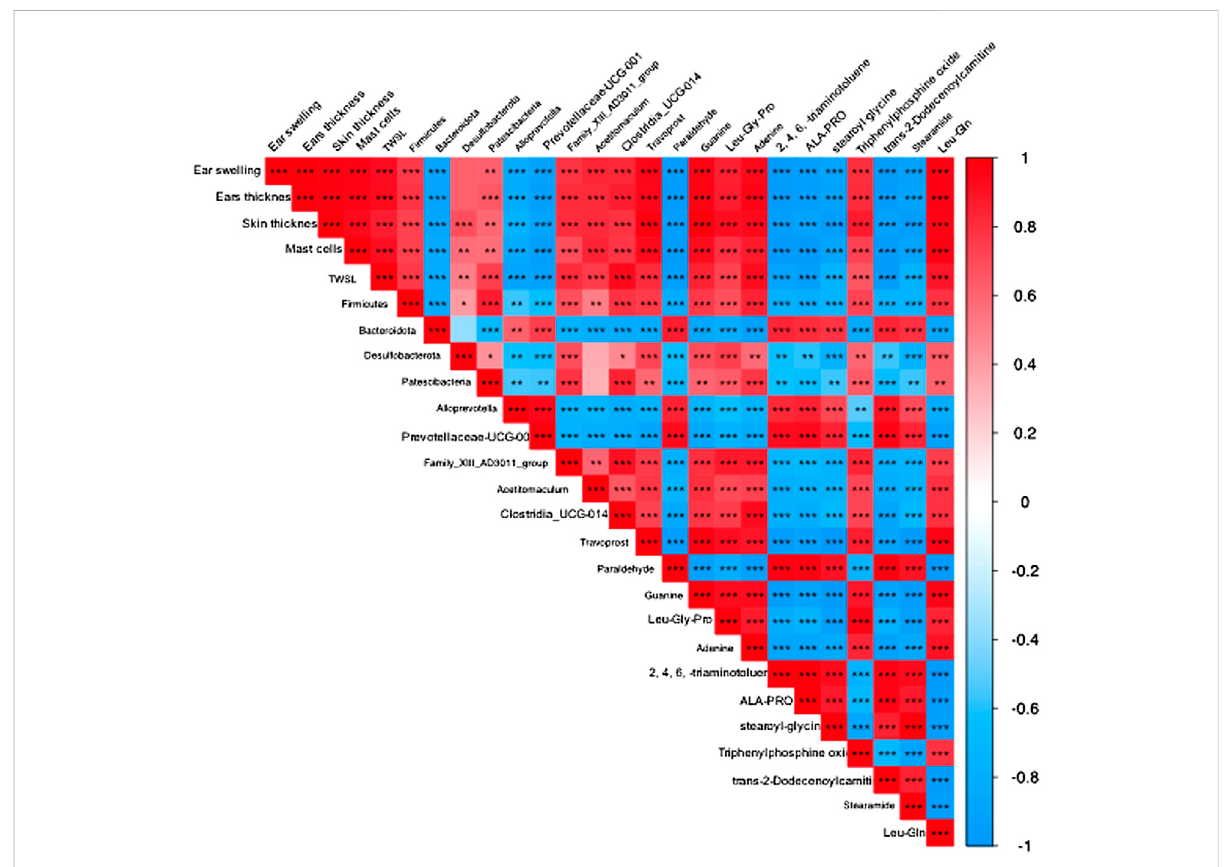
FIGURE 12 Correlation among AD symptoms, relative abundance of gut bacterial and metabolite changes. The correlation was determined using the Spearman ’ s rank correlation analysis. The red color indicates positive correlation, and the blue color indicates negative correlation. p p < 0.05, pp p < 0.01, ppp p <